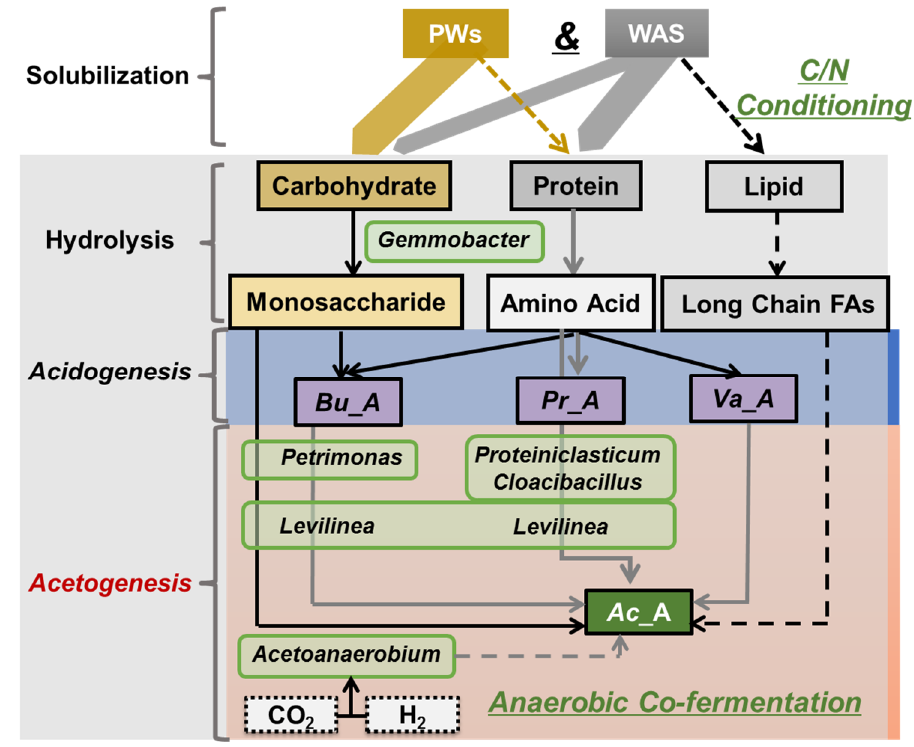
Figure 5. Proposed underlying mechanism of bio-carbon source recovery from WAS fermentation by conditioning with PWs.